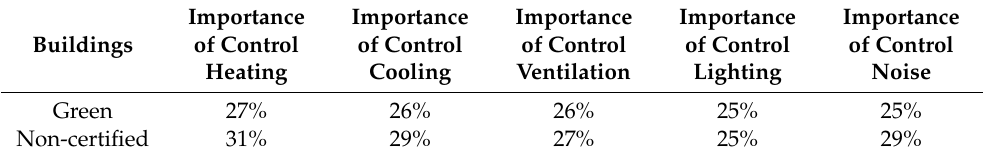
Table 7. “Importance of personal control” question where respondents ticked a box if it was important to